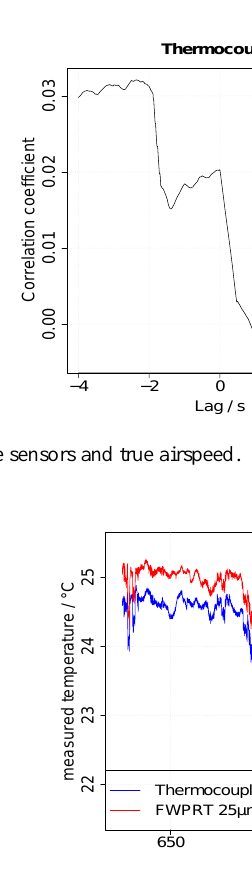
Fig. 16. Time series of thermocouple (blue) and FWPRT (red) in